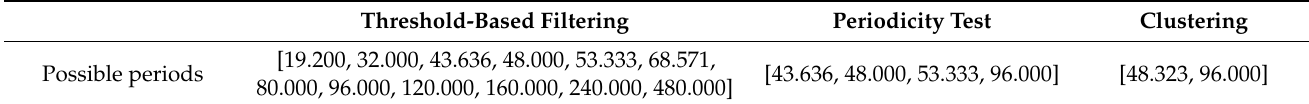
Table 2. The results of multi-period